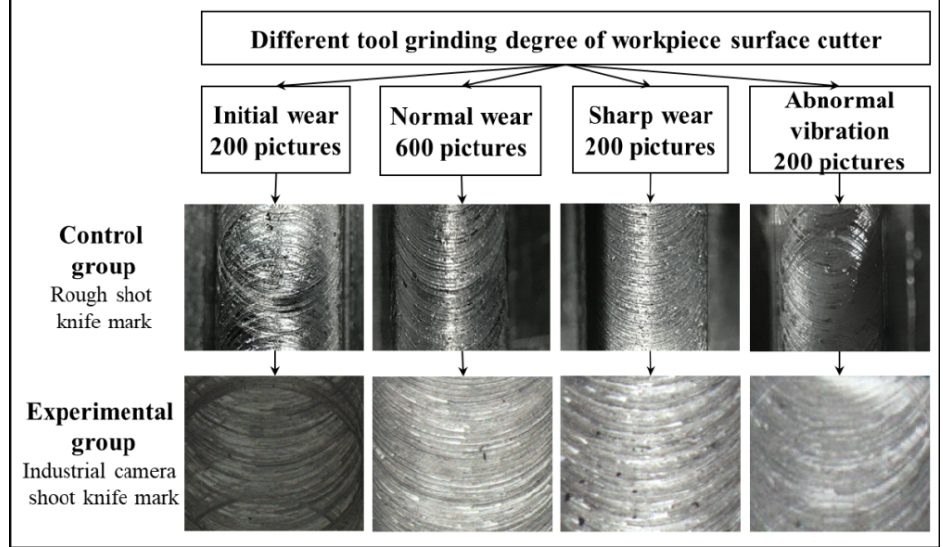
Figure 10. Workpiece surface knife mark in four